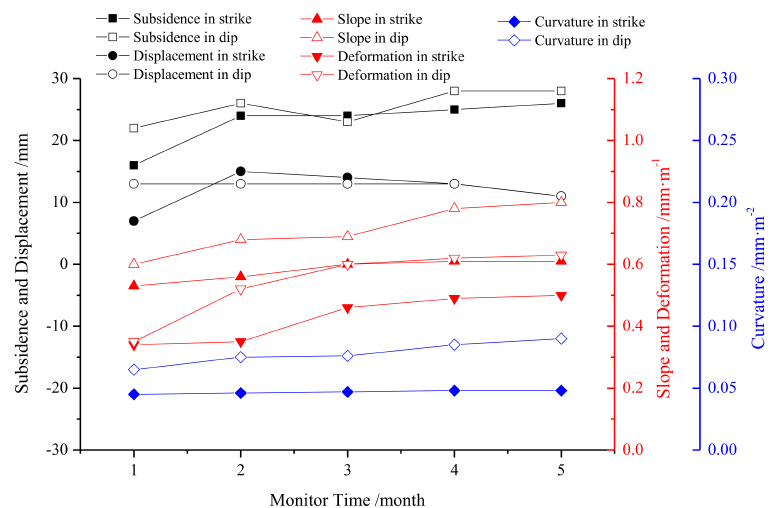
Figure 16. Indices of ground movements along the measuring line in strike and dip direction after